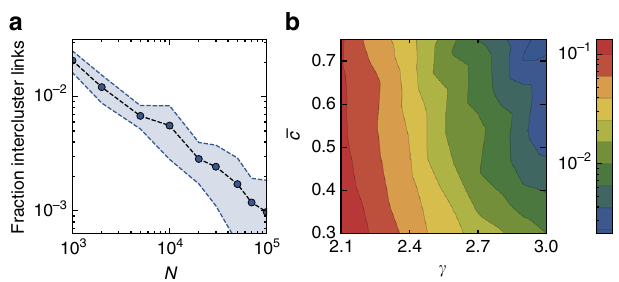
Fig. 6 Intercluster links. a Fraction of links between nodes in a metric cluster spanning half of the network to nodes outside of the cluster compared to the total number of links in the network as a function of the network size for synthetic networks with power-law exponent γ = 2.9, c ¼ 0 : 6, and mean degree k h i ≈ 6. The shaded area denotes one standard deviation from top to bottom. b The same fraction of links (color coded) for synthetic networks with N = 2 × 10 4 nodes and k h i ≈ 6 as a function of the power-law exponent γ and mean local clustering